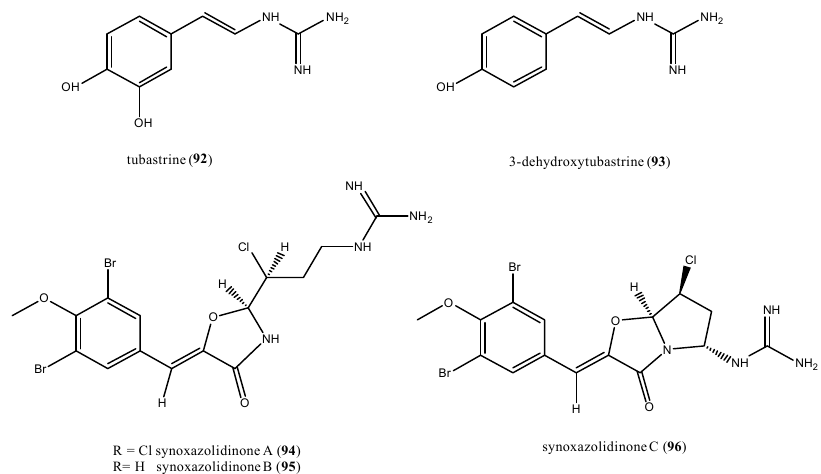
Figure 11. Structures of the guanidine alkaloids tubastrine ( 92 ), 3-dehydroxy tubastrine ( 93 ), and synoxazolidinones A–C ( 94 – 96 ).